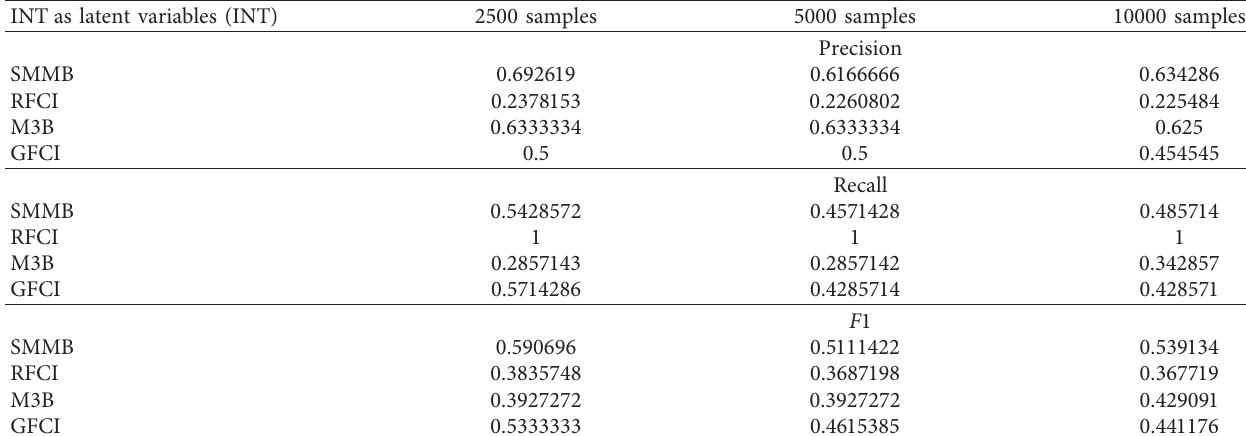
Table 2: When INTis used as a latent variable, SMMB algorithm is compared with RFCI, M3B, and GFCI algorithms in accuracy, recall rate, and F 1 value.